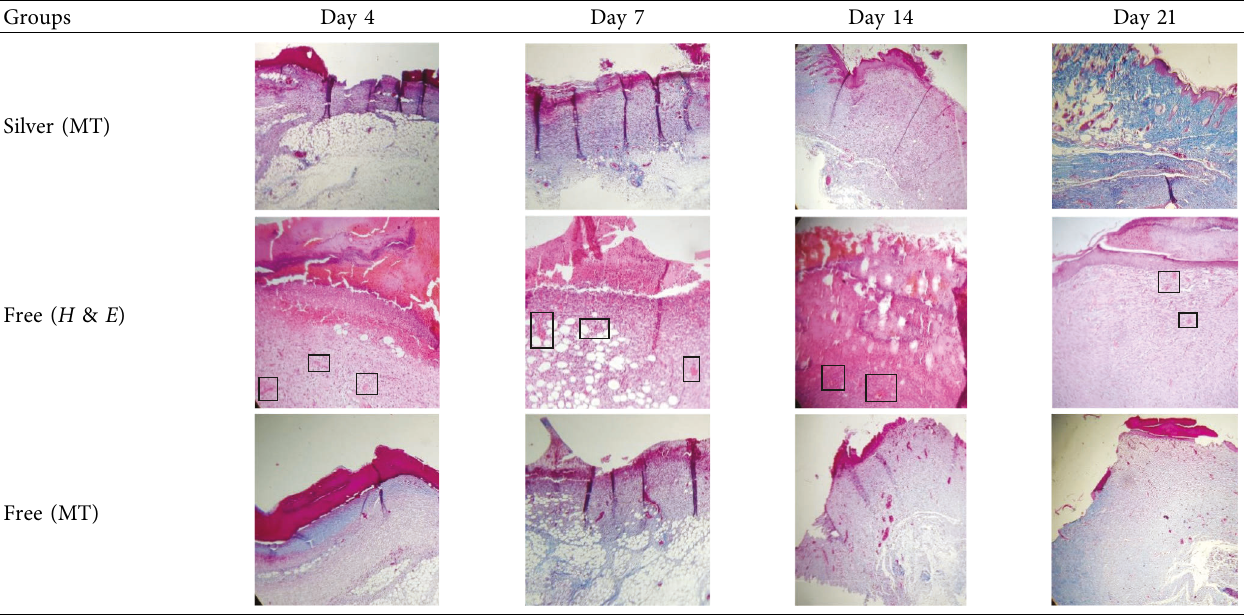
Squares represent morphological changes such as congestion, edema, inflammation, necrosis, and